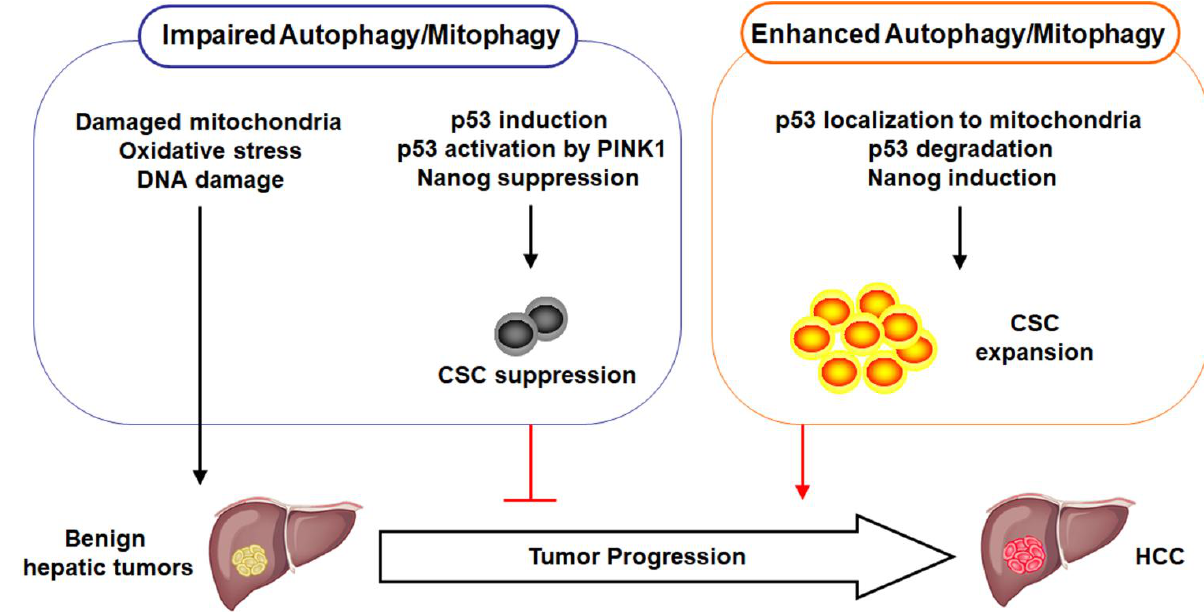
FIGURE 1: Illustration of the roles of autophagy and mitophagy in hepatocarcinogenesis. When autophagy or mitophagy is impaired, damaged mitochondria accumulate in the cell, resulting in increased oxidative stress and DNA damage and the initiation of hepatocarcinogenesis. At the same time, this impairment in autophagy or mitophagy induces the expression of p53, which is further activated by PINK1 to suppress the ex- pression of NANOG and the production of CSCs. Consequently, the progression of benign hepatic tumors into HCC is inhibited. In contrast, when autophagy/mitophagy is enhanced, p53 is associated with mitochondria and subsequently degraded. This leads to the induction of NANOG and the expansion of CSCs to promote the development of